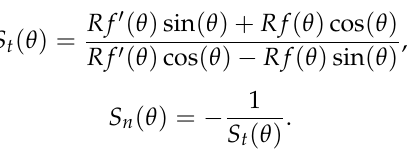
Table 2. Characteristic parameters of the four different prey types considered: small, medium, large, and elongated, denoted by s , m , l , and e , respectively. Dimensions are given in µ m. Only Prey smaller than the filter